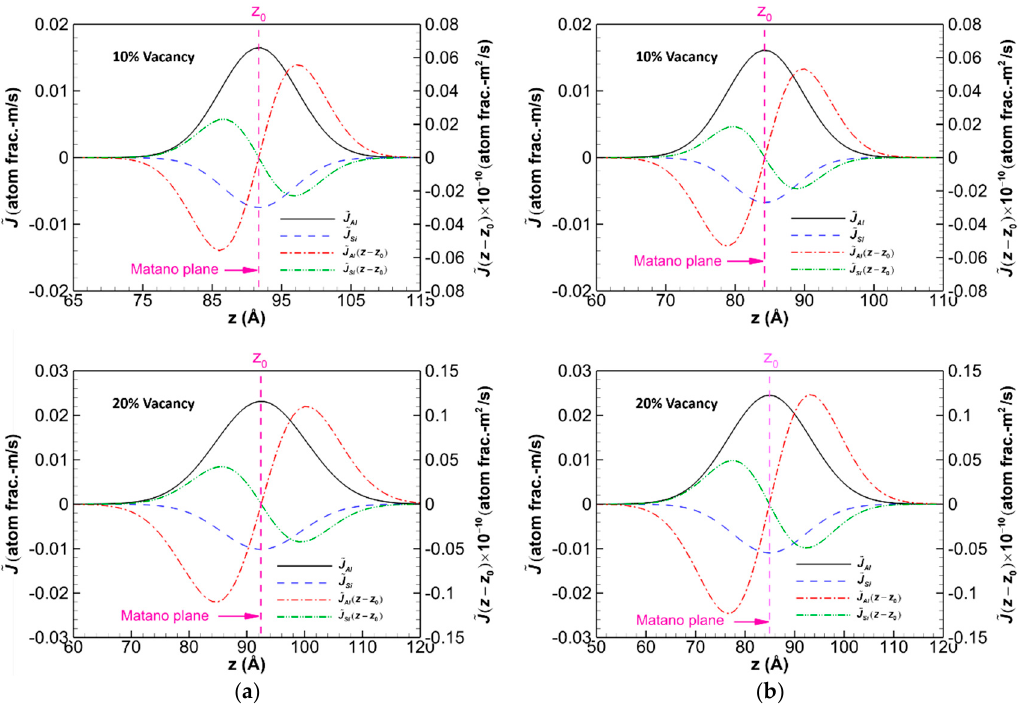
Figure 6. Profiles of the interdiffusion fluxes J and − nated ( a ) 6H-SiC/Al and ( b ) 3C-SiC/Al with 10% and 20% vacancy in SiC annealed at 1000 K for 6 ns.